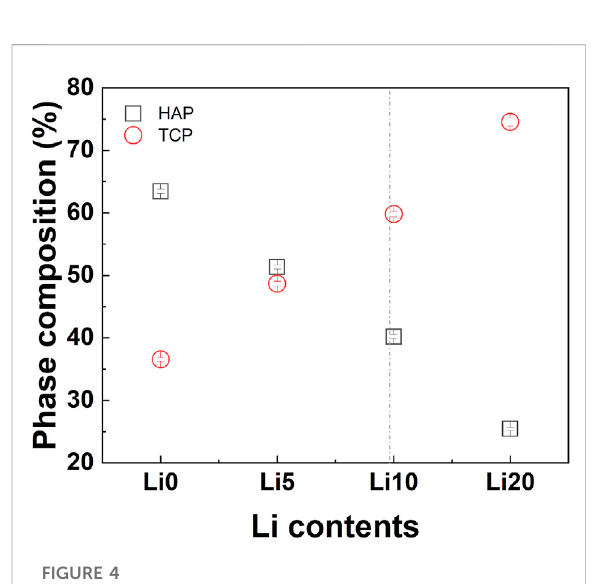
FIGURE 4 Quantitative phase estimation results from the Rietveld re fi nement; squares and circles indicate the weight amounts of HAP and B-TCP, respectively. The vertical line for maximum